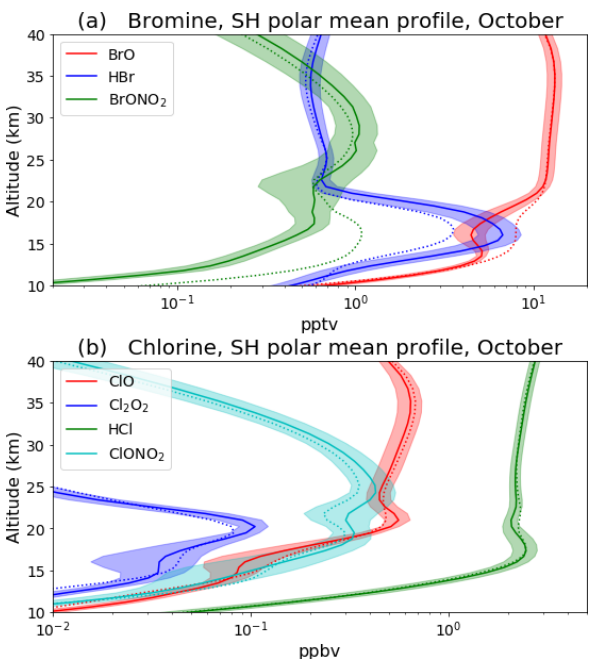
Figure 10. Vertical profile of (a) the species: BrO, HBr and BrONO 2 and (b) ClO, Cl 2 O 2 , HCl and ClONO 2 for October, av- eraged over 1996–2009 and south of 65 ◦ S. “New het.” is shown with solid curves and the control run with dashed curves. Shading indicates ± 1 standard deviation around the “new het.”